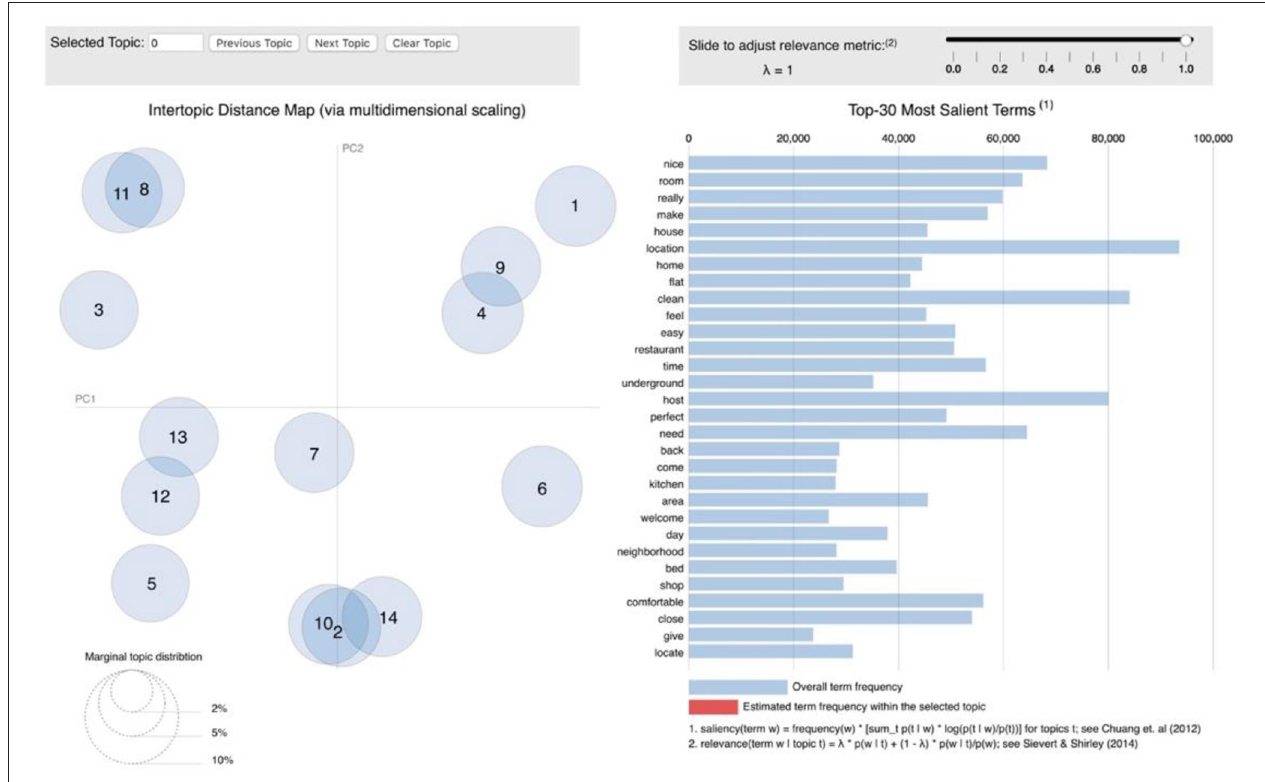
FIGURE 5 | LDAvis visualization (positive reviews). Source: created by the